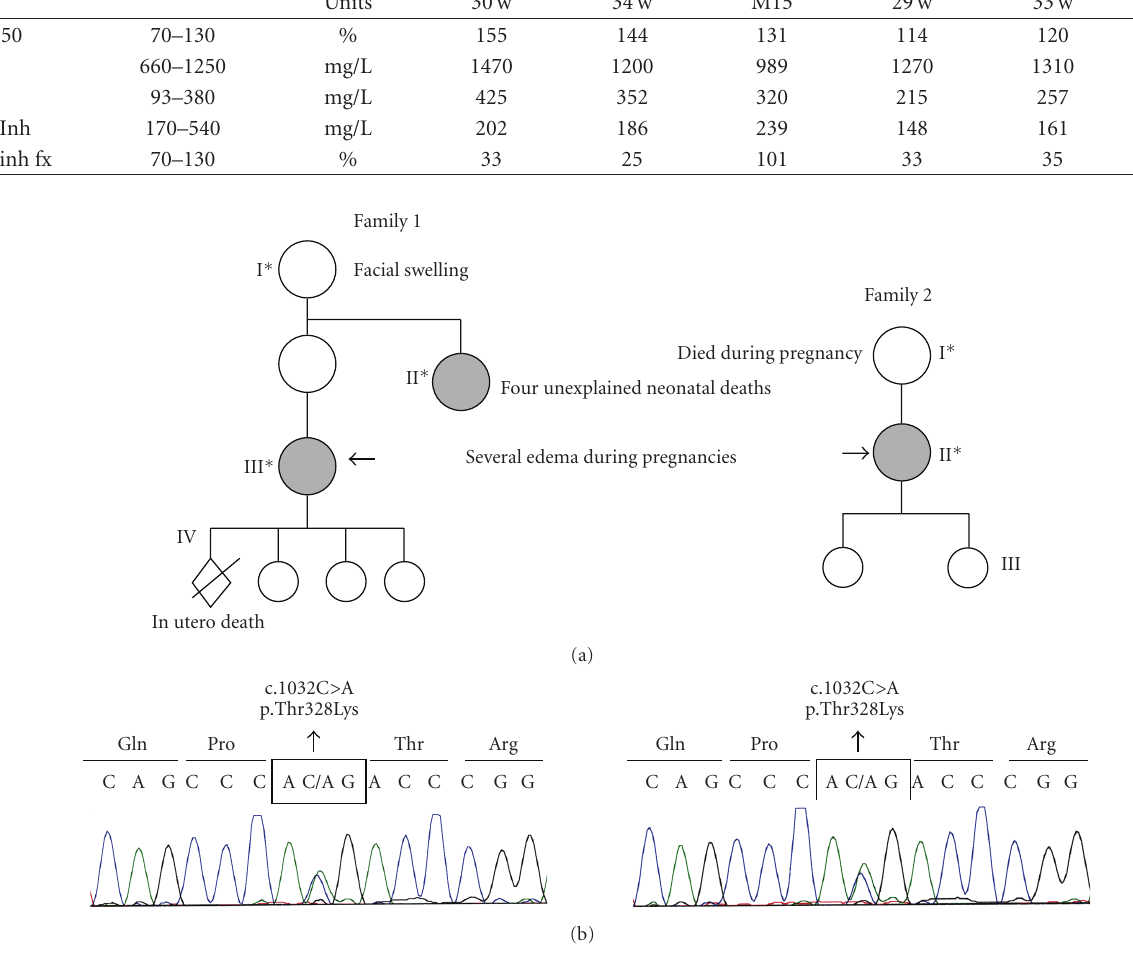
Figure 1: Mutation in the F12 gene in two pedigrees. The pedigree of the two families is shown. Individuals are identified by Arabic numerals within each generation (roman numerals). A ff ected individuals are indicated with asterisks. A heterozygous mutation was found in subjects with solid symbols. Electrophoregrams correspond to the DNA sequence surrounding the mutated nucleotide in the F12 gene. In exon 9, a C > G heterozygous missense mutation was noted in both patients. Direct sequencing of forward and reverse strands was carried out with the BigDye terminator cycle sequencing kit (Applied Biosystems), using the same primers as for PCR amplification (5 (cid:2) -3 (cid:2) F AAGCGCGGAACTGGGGAC; R CCG